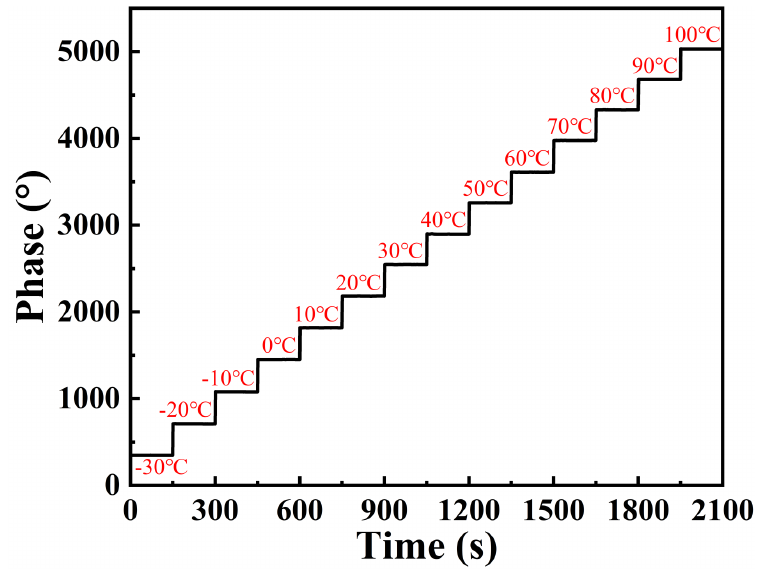
Figure 6. Dynamic response of the proposed sensor towards temperature range of − 30 ◦ C ∼ 100 ◦ C. a b